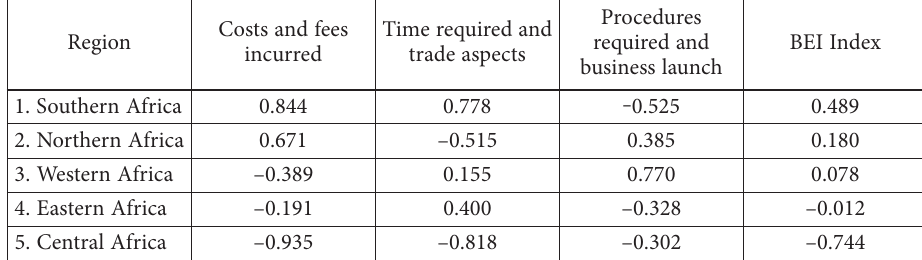
Table 4. The hierarchy of African regions according to BEI Index (source: authors’ calculation) Procedures Costs and fees Time required and required Region incurred trade aspects